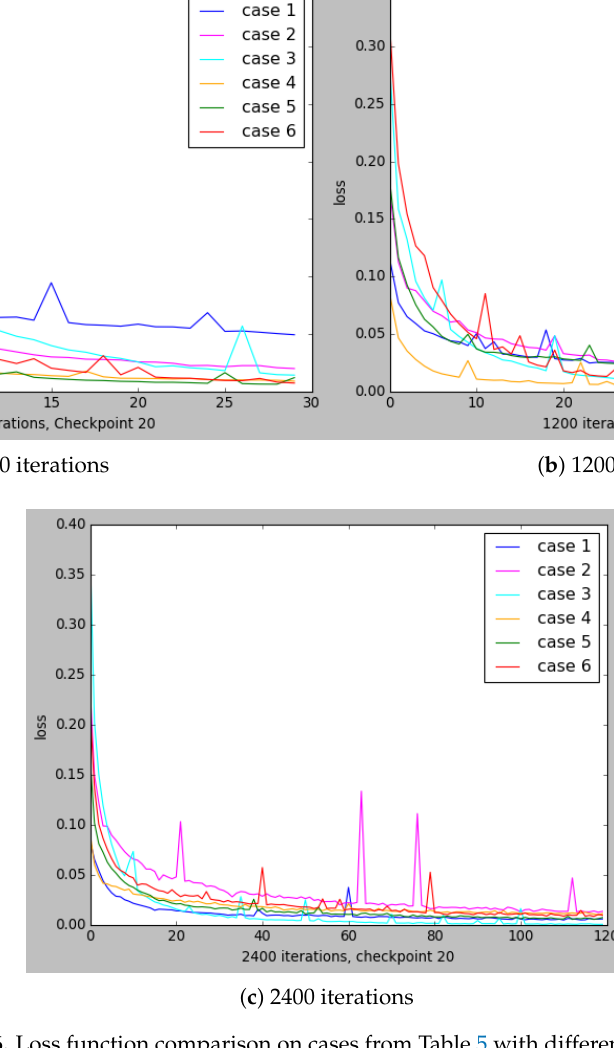
Figure 6. Loss function comparison on cases from Table 5 with different